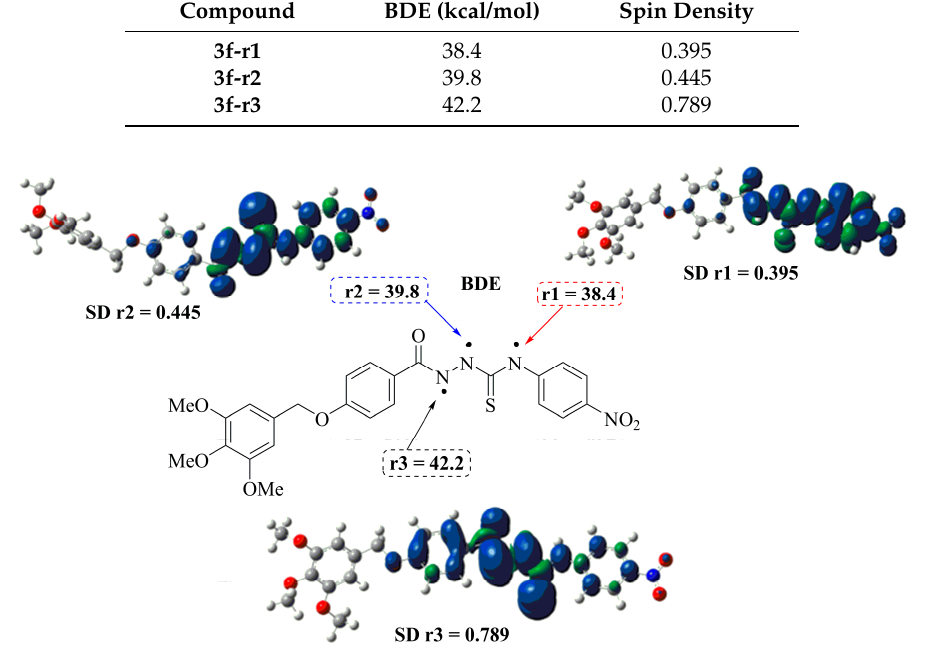
Figure 4. Density distributions of the SOMOs, BDE and SD calculated on the r1-N , r2-N and r3-N atoms in their radicals of compound 3f .